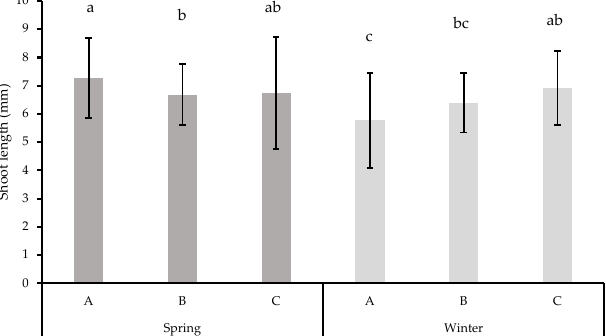
Figure 5. Shoot lengths of camelina (mm) in response to the interaction biotype (winter vs. spring) × seed weight class ((A) TSW > 1.27 g vs. (B) 0.98 g < TSW < 1.27 g vs. (C) TSW < 0.98 g). Mean values ± SE. Different letters: statistically different means for P ≤ 0.05 (LSD’s test).